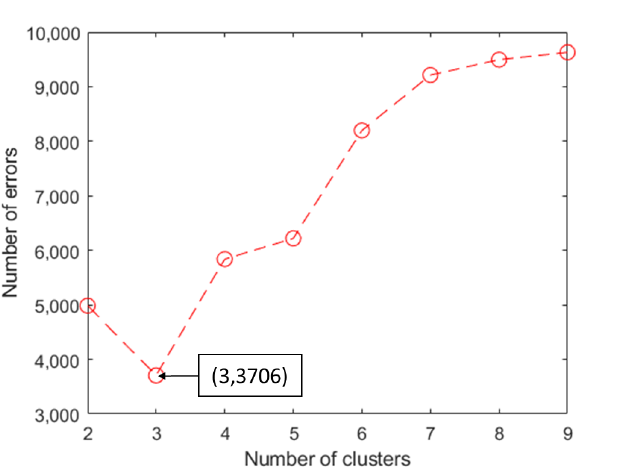
Figure 2. Instability analysis of k-means clustering results for different values of k